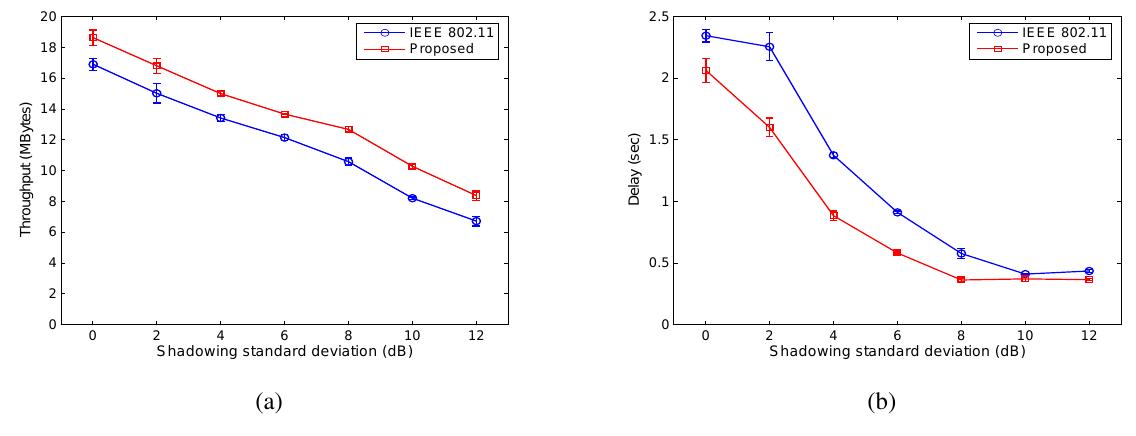
Figure 13. Simulation results for random networks when σ 12 dB. (a) Throughput. (b)